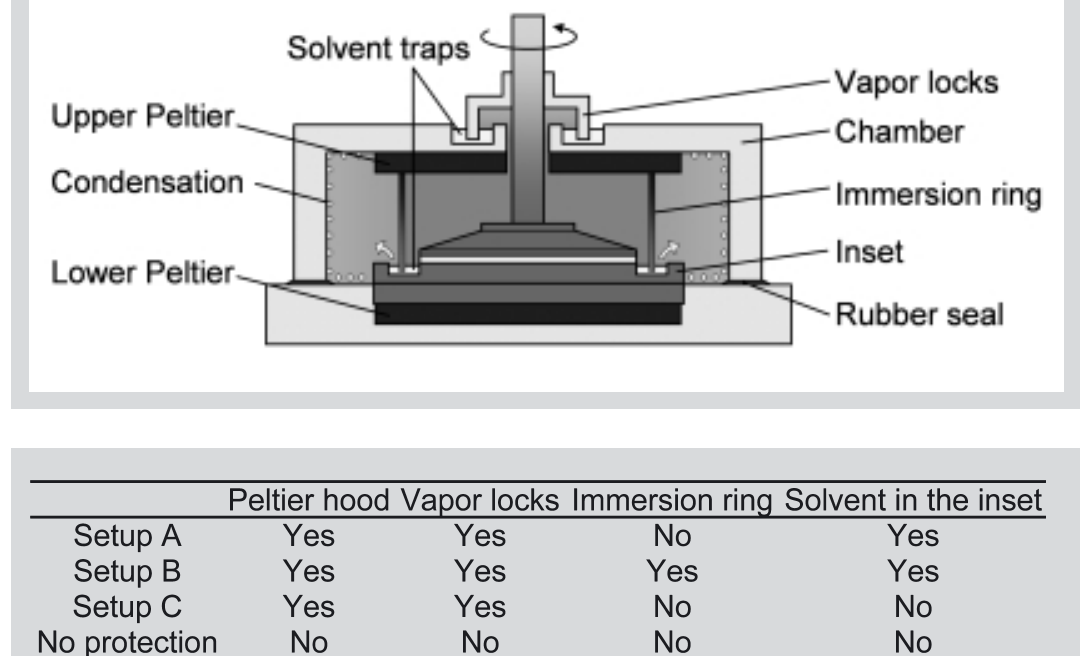
Figure 1: Schematic illustration of the evaporation blocking system. Table 1: Setup of the evaporation blocking system for water